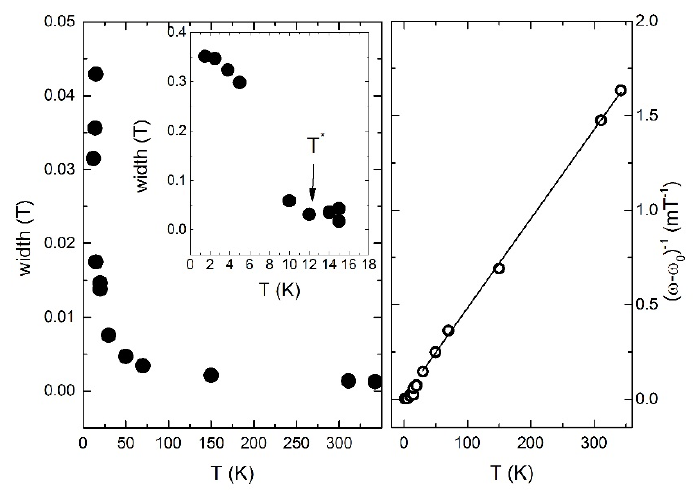
Figure 8. ( Left ) The temperature dependence of 7 Li NMR linewidth ω ( T ). Inset presents the low- Figure 8. Left ) The temperature dependence of 7 Li NMR linewidth ω( T ). Inset presents the low- temperature part of the ω ( T ) dependence. ( Right ) Inverse linewidth vs. temperature (see text temperature part of the ω ( T ) dependence. Right ) Inverse linewidth vs. temperature (see text for for details). details).